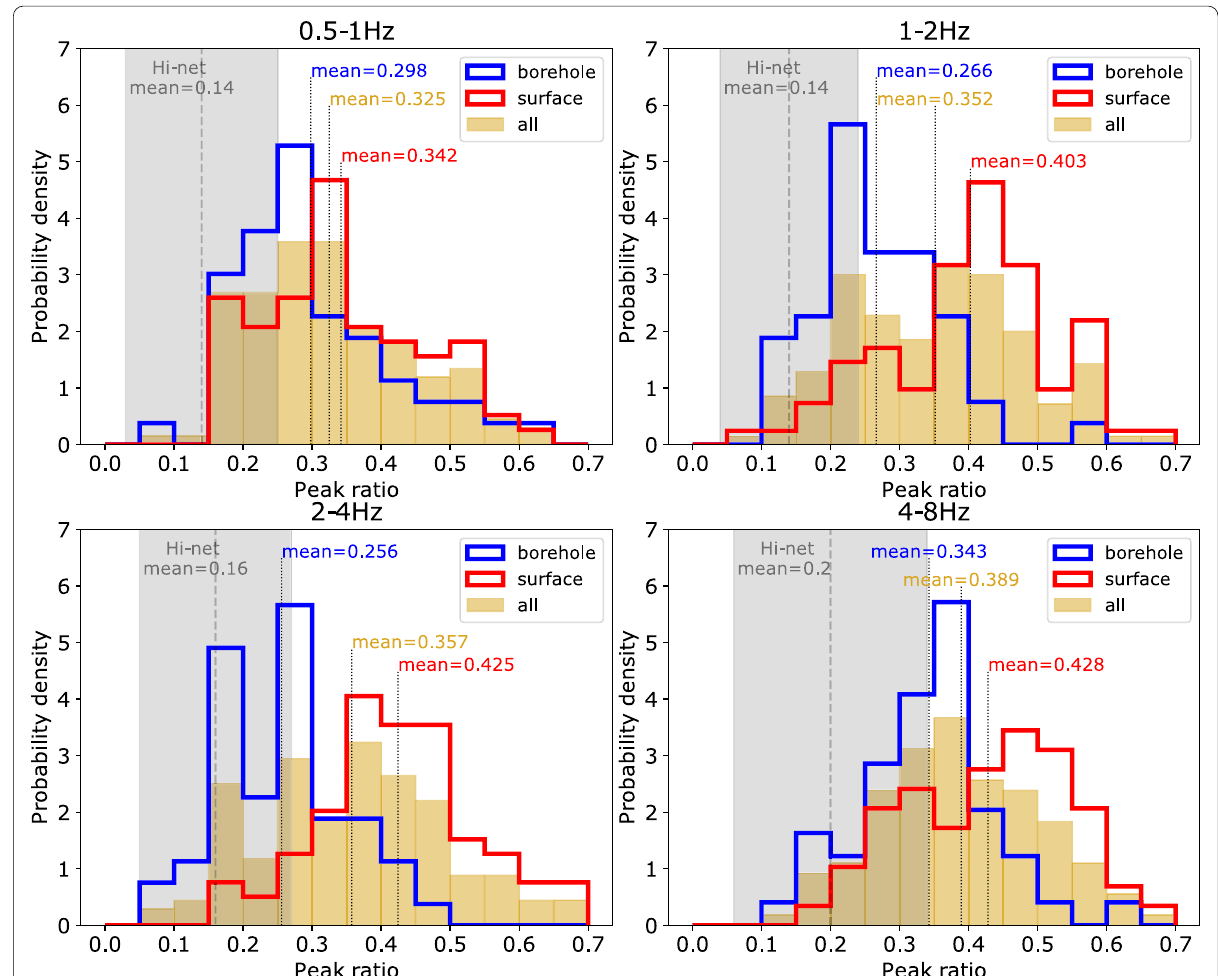
Fig. 3 Histograms showing the probability density functions of peak amplitude ratios for the four frequency bands: 0.5–1, 1–2, 2–4, and 4–8 Hz. Yellow histograms show the distributions of peak ratios when all JMA stations are considered. Red and blue histograms separate the peak ratio distributions into JMA ground surface and borehole stations, respectively. The former is showing mostly larger values, and both are greater than the reference numbers for the Hi-net stations. The grey bands indicate the peak ratio mean plus-and-minus one standard deviation for all Hi-net data according to Table 1 of Nishimura